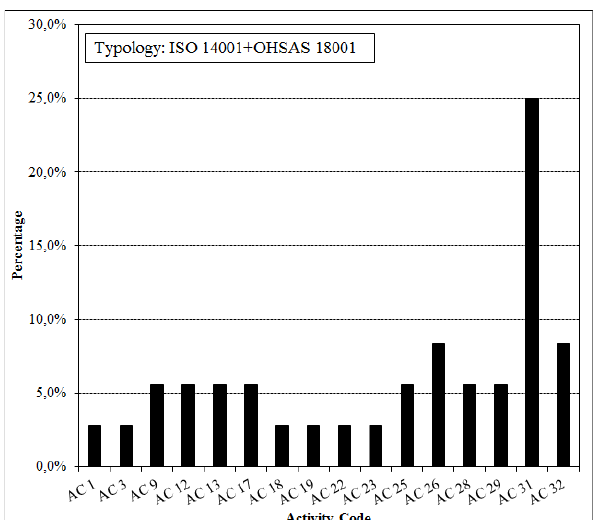
Figure 12. Integrated Typology ISO 9001+OHSAS 18001: Breakdown by activity sectors.